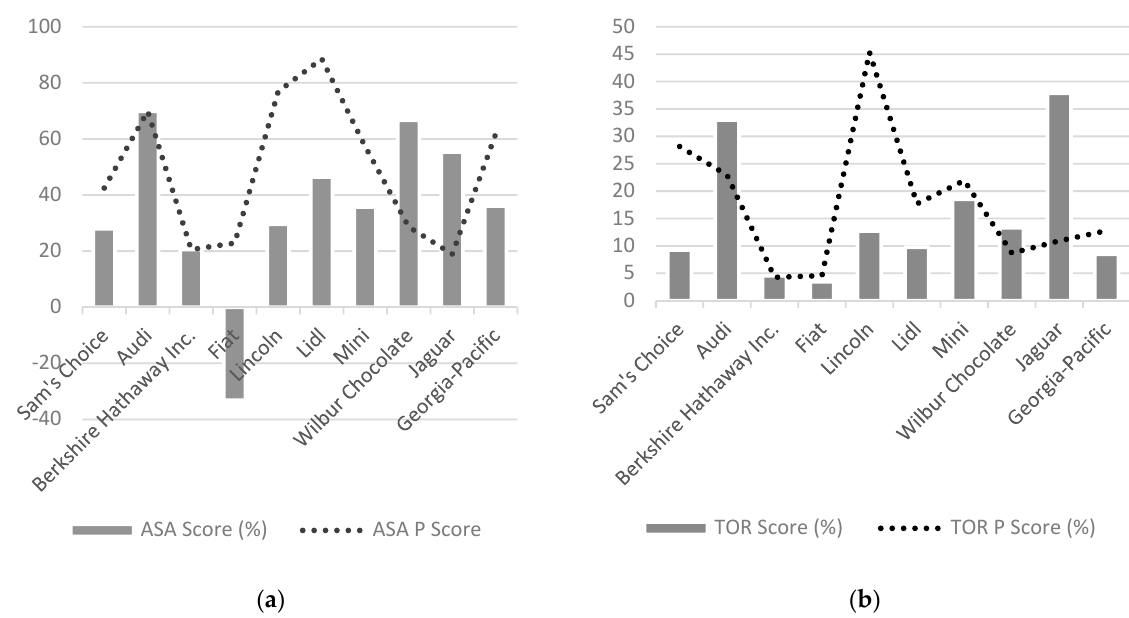
Figure 1. comparison of the parent companies against their brands: ( a ) results of the Advanced sentiment analysis (ASA); ( b ) results of the total level of online reputation (TOR).